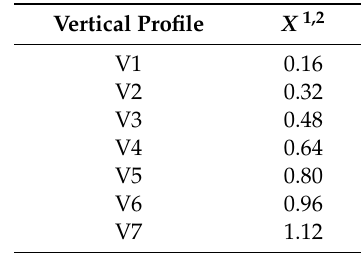
Table 5. Normalized position of the velocity profiles measured in the experimental campaign.